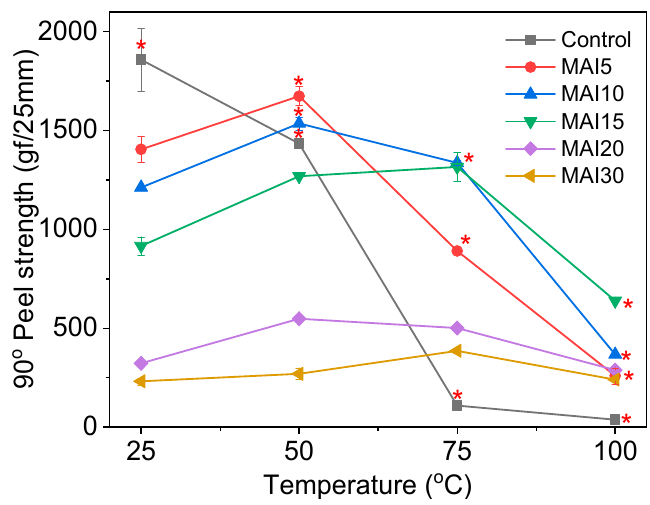
Figure 5. 90° peel strength of various SPSAs as a function of temperature. The red asterisk denotes cohesive failure. Polymers 2020 , 12 , x FOR PEER REVIEW